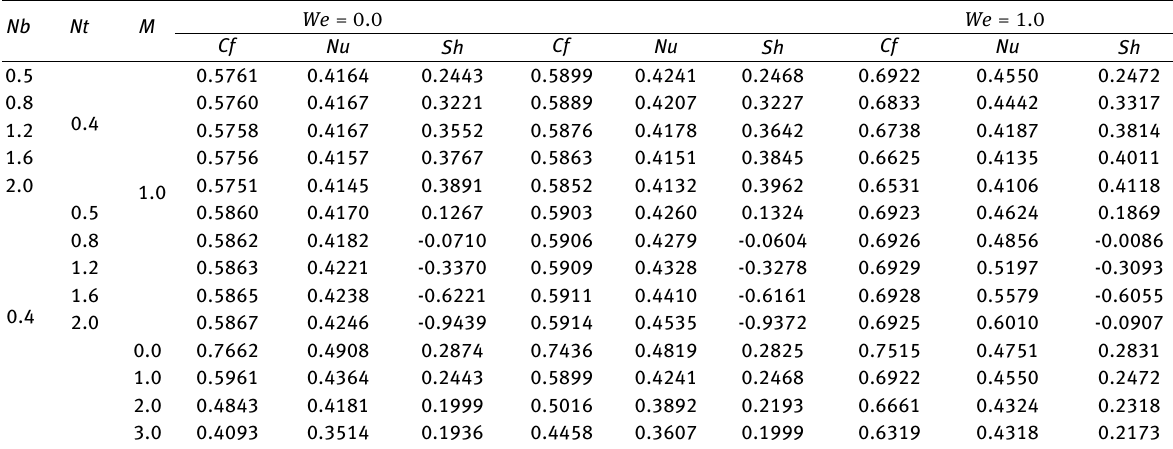
Figs. 4a-c present the evolution in velocity, tempera- ture and concentration functions with a variation in mag- netic body force parameter ( M ). The radial magnetic field generates a transverse retarding body force. This decel- erates the boundary layer flow and velocities are there- fore reduced as observed in Fig. 4a. The momentum